Question: Provide a one-line summary of what is displayed.
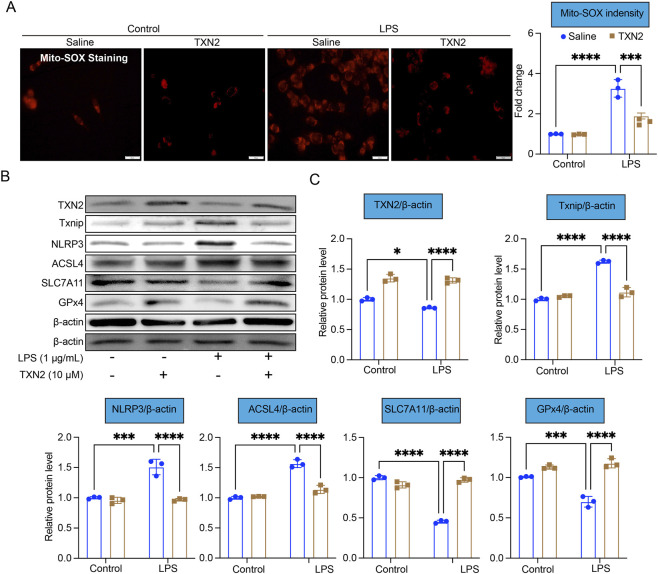
Answer: Effects of MitoQ on TXN2-mediated protection against mtROS and ferroptosis. (A) Mito-SOX staining of mtROS (left, n = 3, scale bar = 20 μm) and quantification of Mito-SOX intensity (right, n = 3). (B) Immunoblotting analysis of TXN2, TXNIP, NLRP3, ACSL4, SLC7A11, GPX4, and β-actin (n = 3). (C) Relative protein levels of each blot (n = 3). The results are expressed as the mean ± SD. * p < 0.05, *** p < 0.001, and **** p < 0.00001.